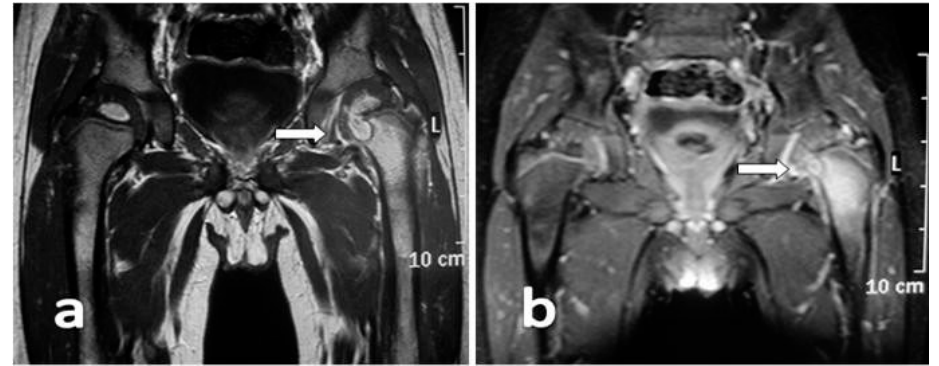
Figure 2. MRI confirms osteomyelitis of the femoral neck with a possible involvement of the growth plate without involvement of the joint cavity (arrow). ( a ) T1-weighted image showing metaphyseal fluid collection with surrounding edema; ( b ) T1-weighted SPIR image enhancing the fluid component.